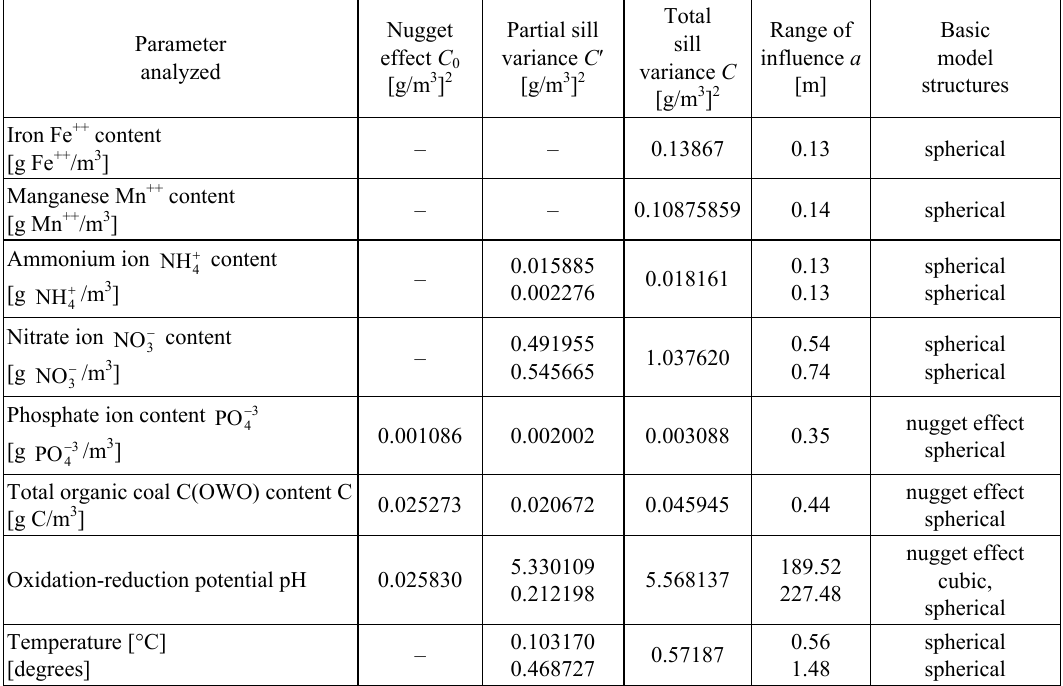
Table 8. Comparison of values of geostatistical models of directional semivariograms D-90 of quality parameters of underground water in area of water intake in the region of Kłodzko;